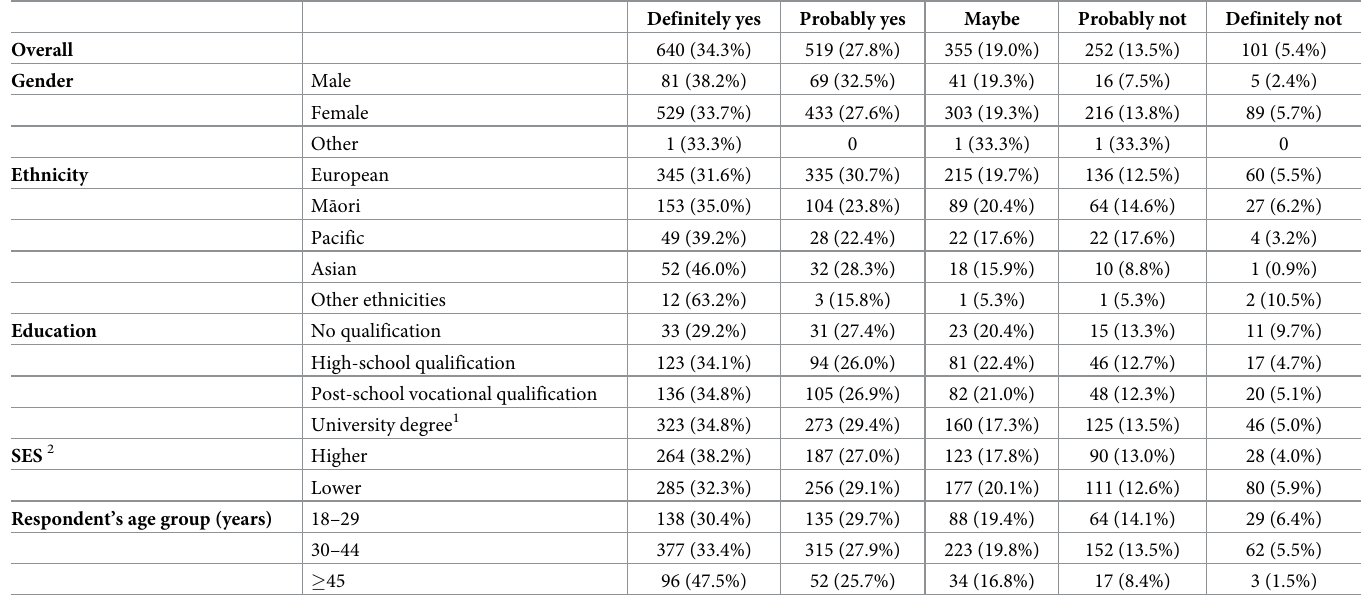
Table 2. Responses to the question ‘Would you like to know this information?’ according to gender, ethnicity, education, and socioeconomic status